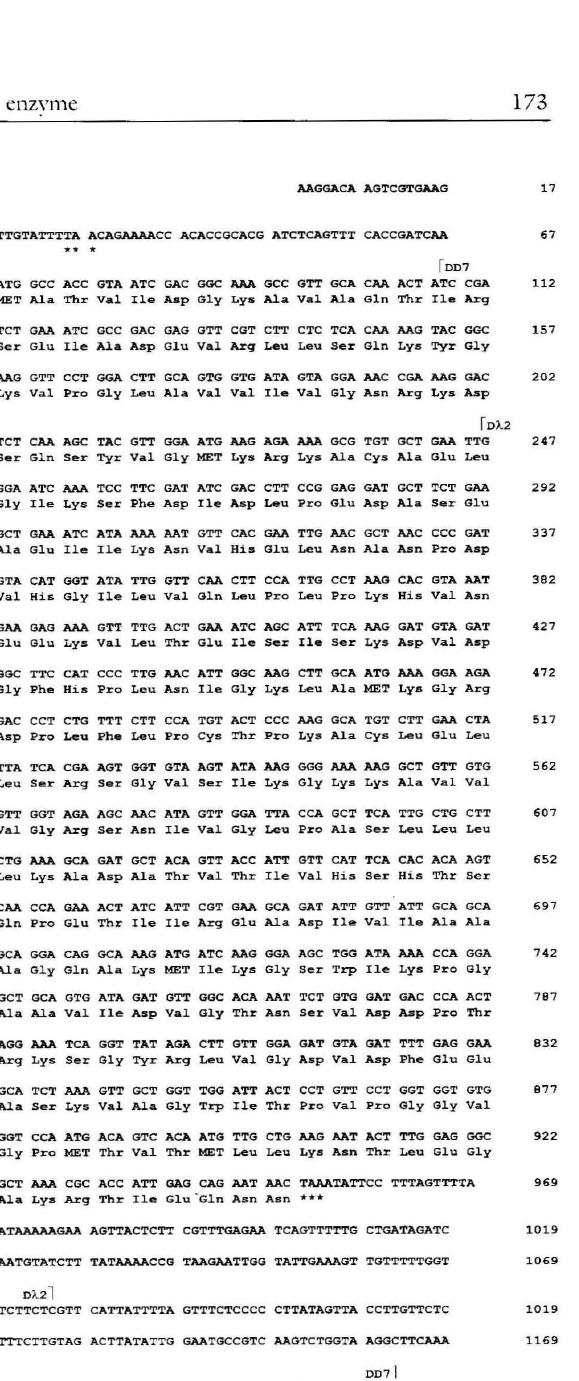
Figure 1. ~ucleotide and deduced amino acid sequence of a 1.2 kb cD~.\ (Clone D3-1 ) encoding cytosolic DHY eye. The nucleotide sequence is numbered sequentially from the first nucleotide. The deduced amino acid sequence commences with the first methionine codon. Stop codons are marked by asterisks. This sequence has been assigned accession number AJO 11589 (EMBL database) and accession number AF030516 (Genbank). The 5' and 3' ends of the r ) and ( l truncated clones, DA2 and DD7, are indicated by ( ) respectively. isolated and the 830 bp eDNA insert (D12) was cloned into pBlueseript and its DNA sequence determined (Figure 1). The deduced amino acid sequence encoded by this eDNA was compared to Ptcridines / Vol. 10 / ;-Jo.